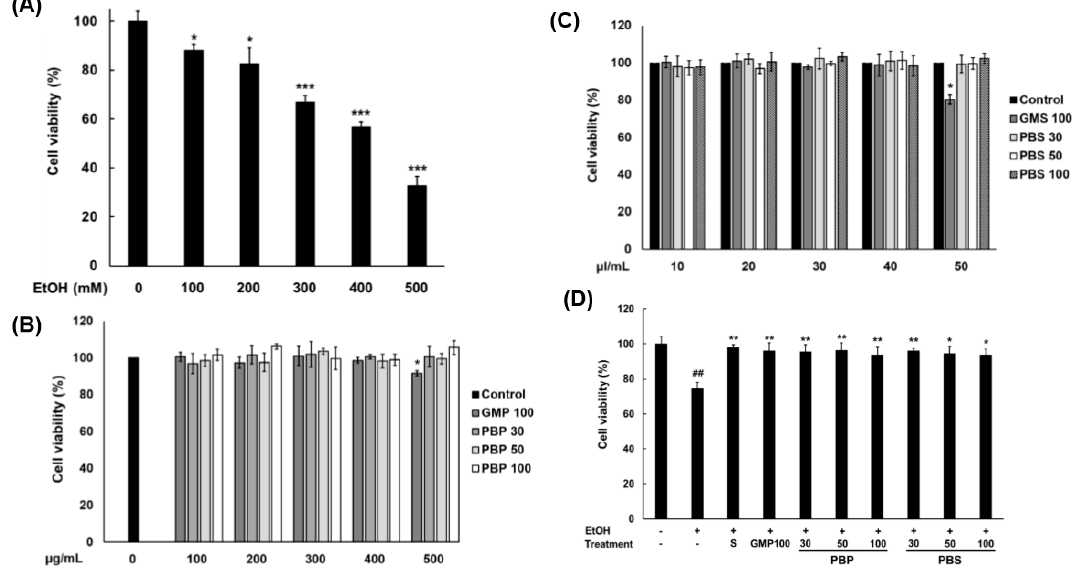
Figure 2. HepG2 cell viability. ( A ) Viability of HepG2 cells treated with 0, 100, 200, 300, 400, and 500 mM EtOH. Values are the means ± standard deviations of triplicate experiments. * p < 0.05 and *** p < 0.001 indicate a significant difference between the 0 mM and the 100, 200, 300, 400, and 500 mM EtOH. ( B , C ) show the cell viability after 300 mM EtOH treatment in the HepG2 cells pretreated with the paste and sauce extracts, respectively, by concentration. Values are the means ± standard deviations of triplicate experiments. * p < 0.05 indicates a significant difference between the control and 500 μ g/mL of the GMP100 treatment. ( D ) Cell viability after 300 mM EtOH treatment in the HepG2 cells pretreated with the paste and sauce extracts. Values are the means ± standard deviations of triplicate experiments. ## p < 0.01 indicates a significant difference between the EtOH ( ‐ )/treatment ( ‐ ) and the EtOH (+)/treatment ( ‐ ). * p < 0.05 and ** p < 0.01, *** p < 0.001 indicate a significant difference between the EtOH (+)/treatment ( ‐ ) and the EtOH (+)/treatment (+). S, silymarin (100 μ g/mL); GMP100, paste made from 100% GM; PBP30, paste made from 30% PBL/70% GM; PBP50, paste made from 50% PBL/50% GM; PBP100, paste made from 100% PBL; GMS100, sauce made from 100% GM; PBS30, sauce made from 30% PBL/70% GM; PBS50, sauce made from 50% PBL/50% GM; PBS100, sauce made from 100% PBL. The concentrations of paste and sauce were 400 μ g/mL and 40 μ l/mL, respectively. Values are the means ± standard deviations of triplicate experiments.